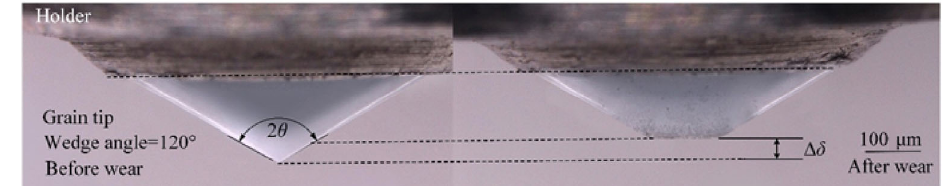
Fig. 10 Wear height of alumina